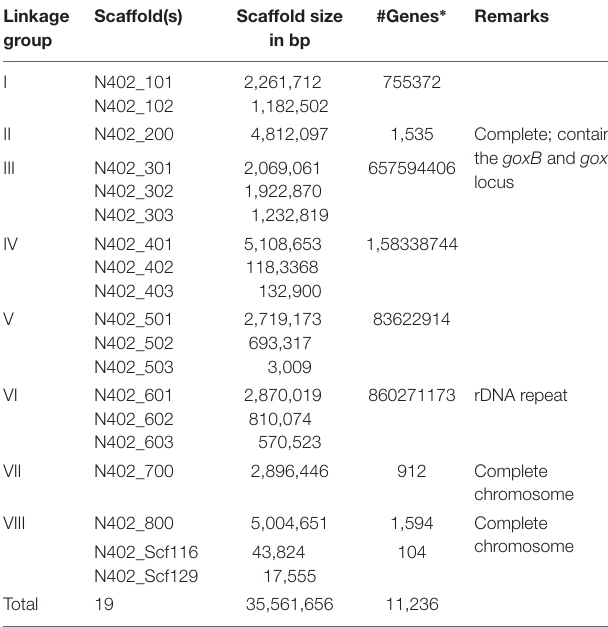
TABLE 1 | Overview of the A. niger N402 genome